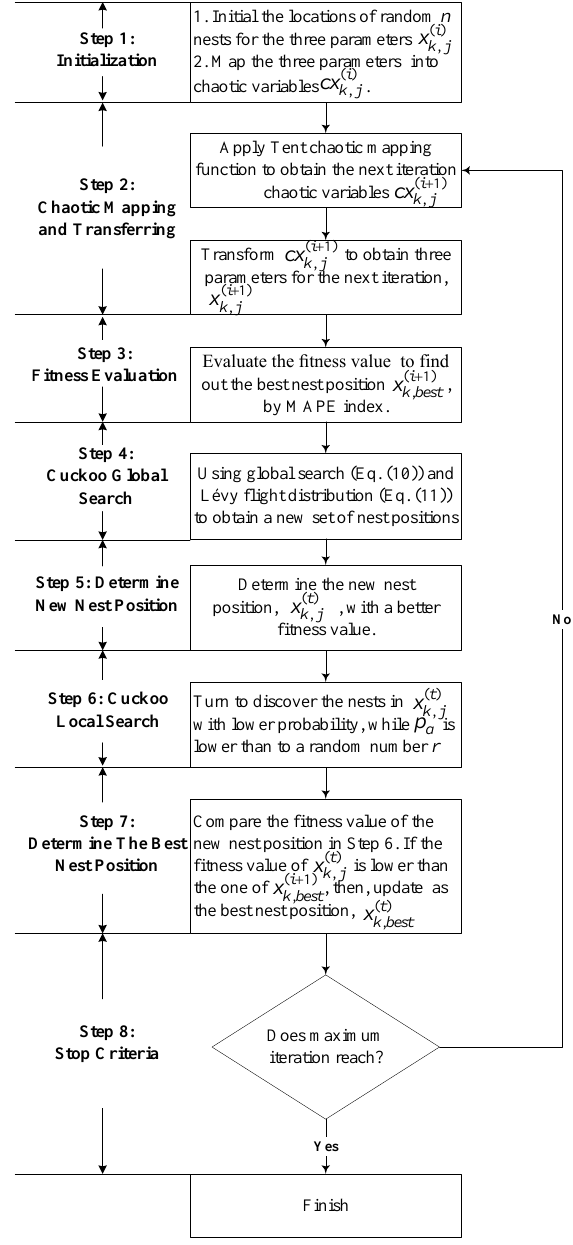
Figure 1. Chaotic cuckoo search algorithm flowchart.